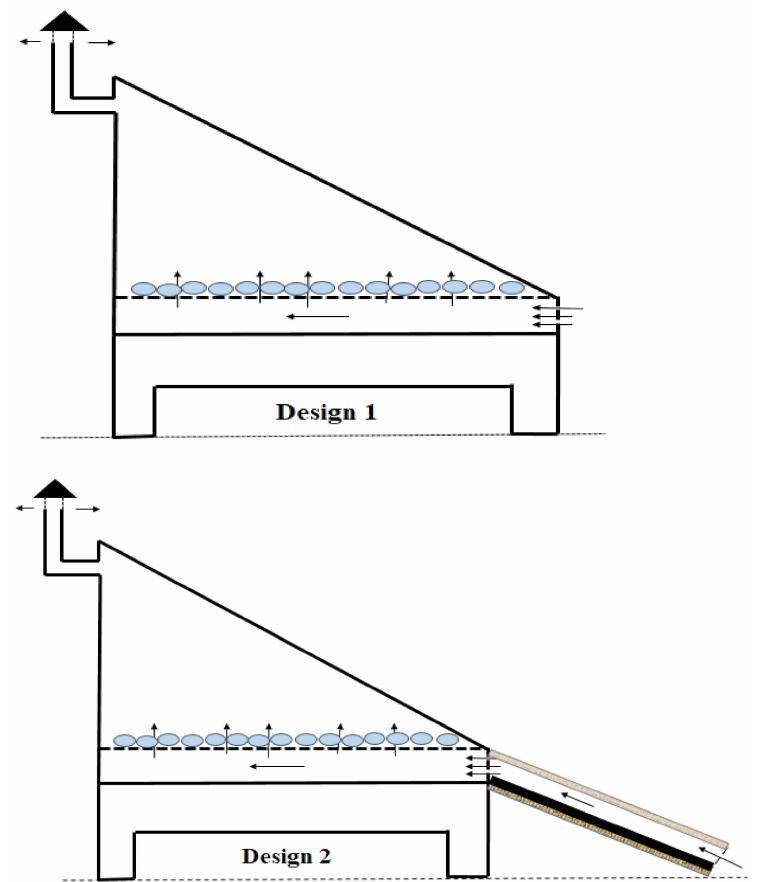
Figure 2. Schematic diagrams of the studied solar dryer without (design 1) and with (design2) a solar collector.